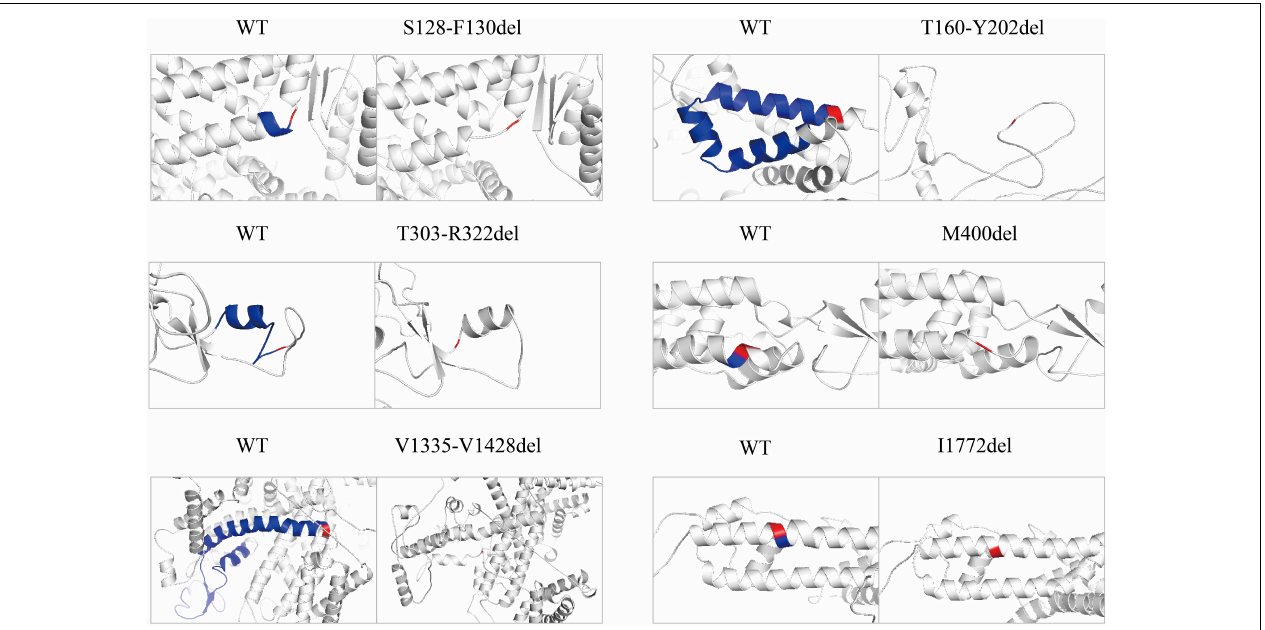
FIGURE 4 | Pairwise comparison of the predicted local structure features between wild-type and in-frame deletions. Location of deleted residues is indicated in blue, and their next residues are in